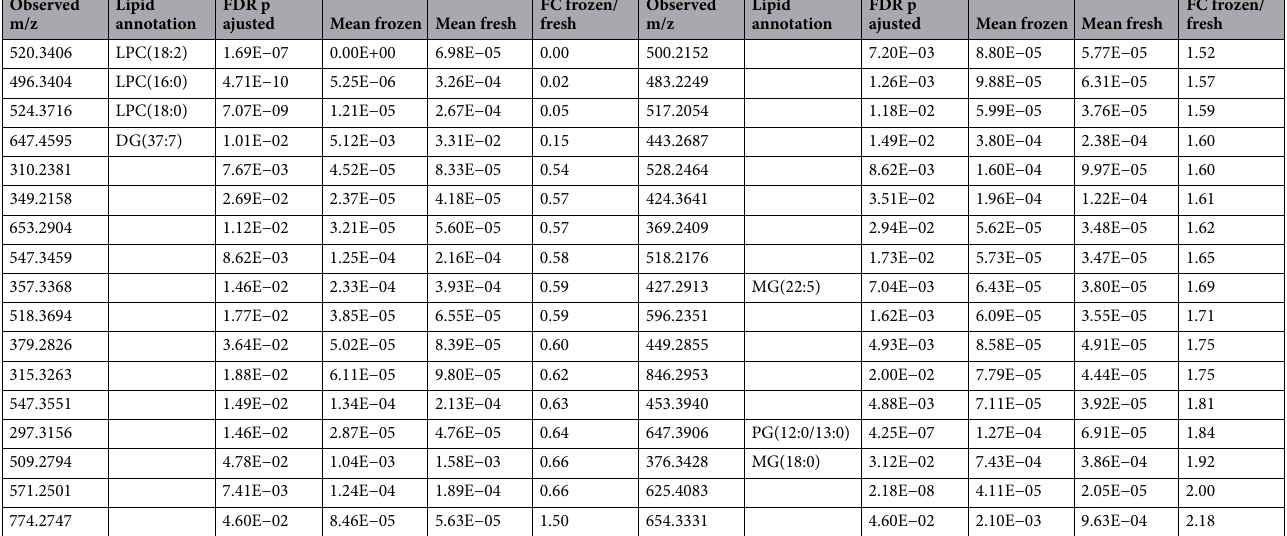
Table 3. Differentially expressed lipids between fresh and frozen in vivo produced embryos. Features with fold-change (FC) > 1.5 or < 0.66 are presented here. p value with FDR (false discovery rate) is presented here. The complete table with lipid annotated features is provided in Supplementary Table